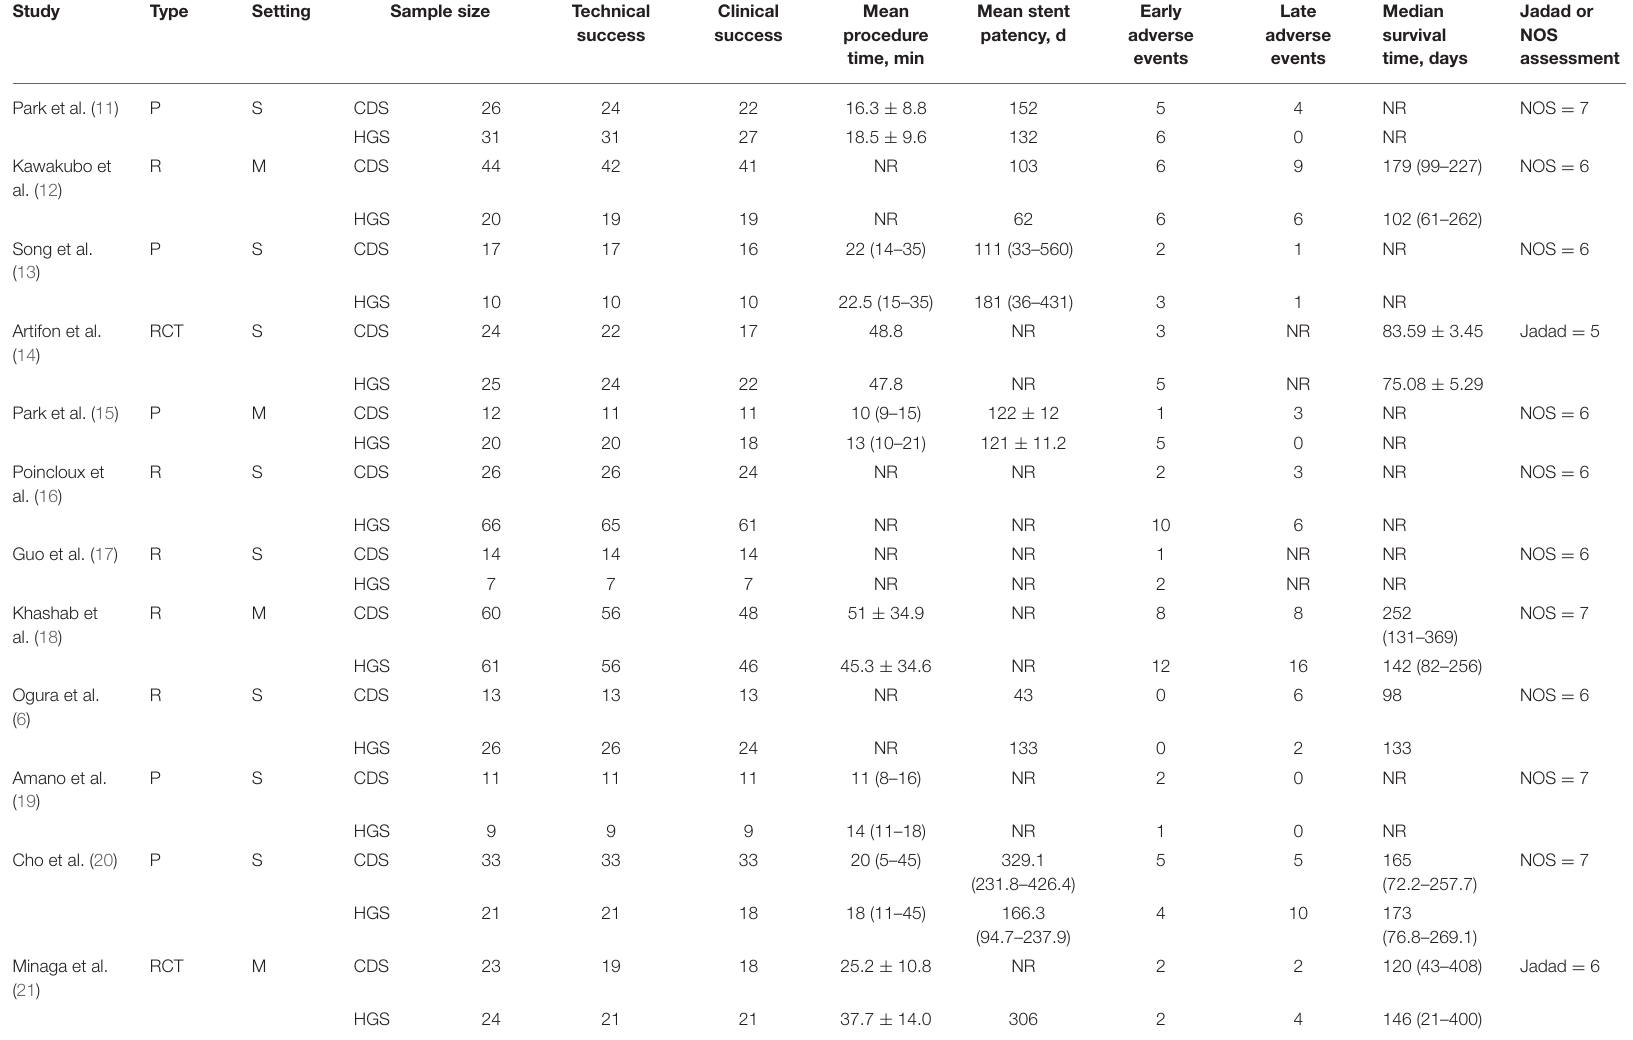
TABLE 1 | The characteristics of included